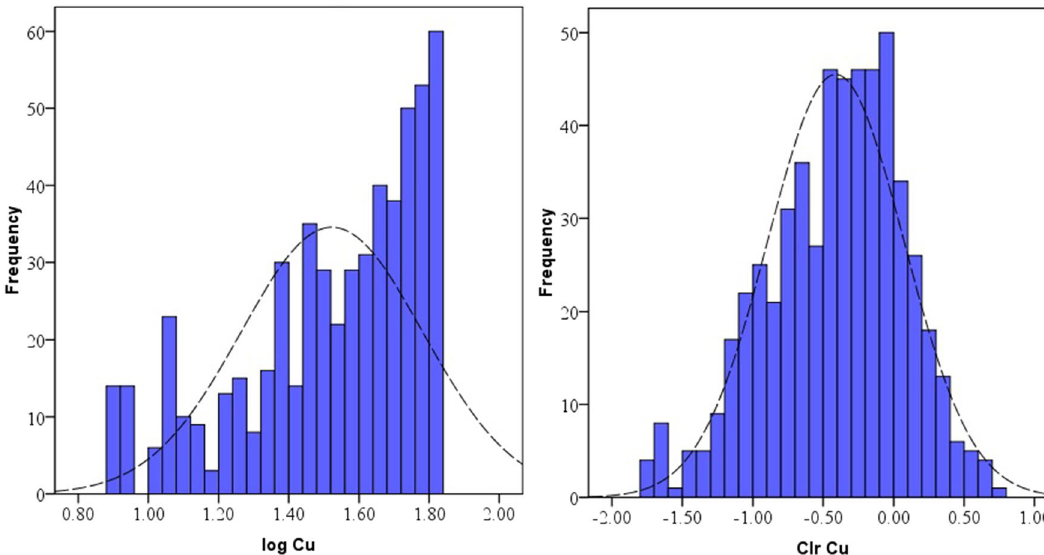
Figure 8. EDA plots for: (a) Cu original log-transformed data; (b) Cu clr-transformed